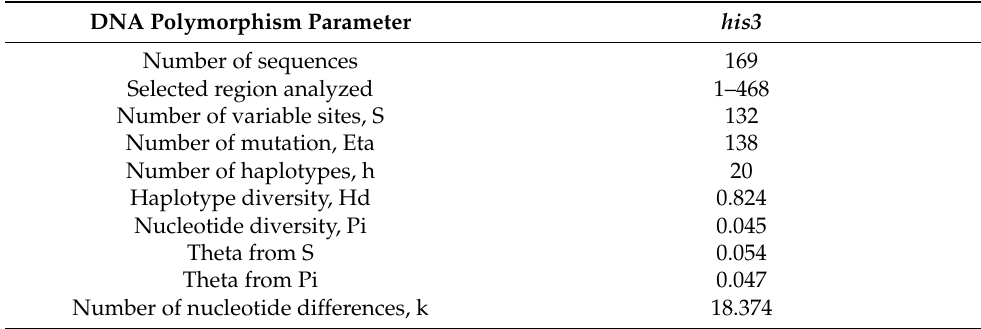
Table 3. DNA polymorphisms of Cylindrocarpon -like fungi based on partial sequences of the his3 gene. DNA Polymorphism Parameter